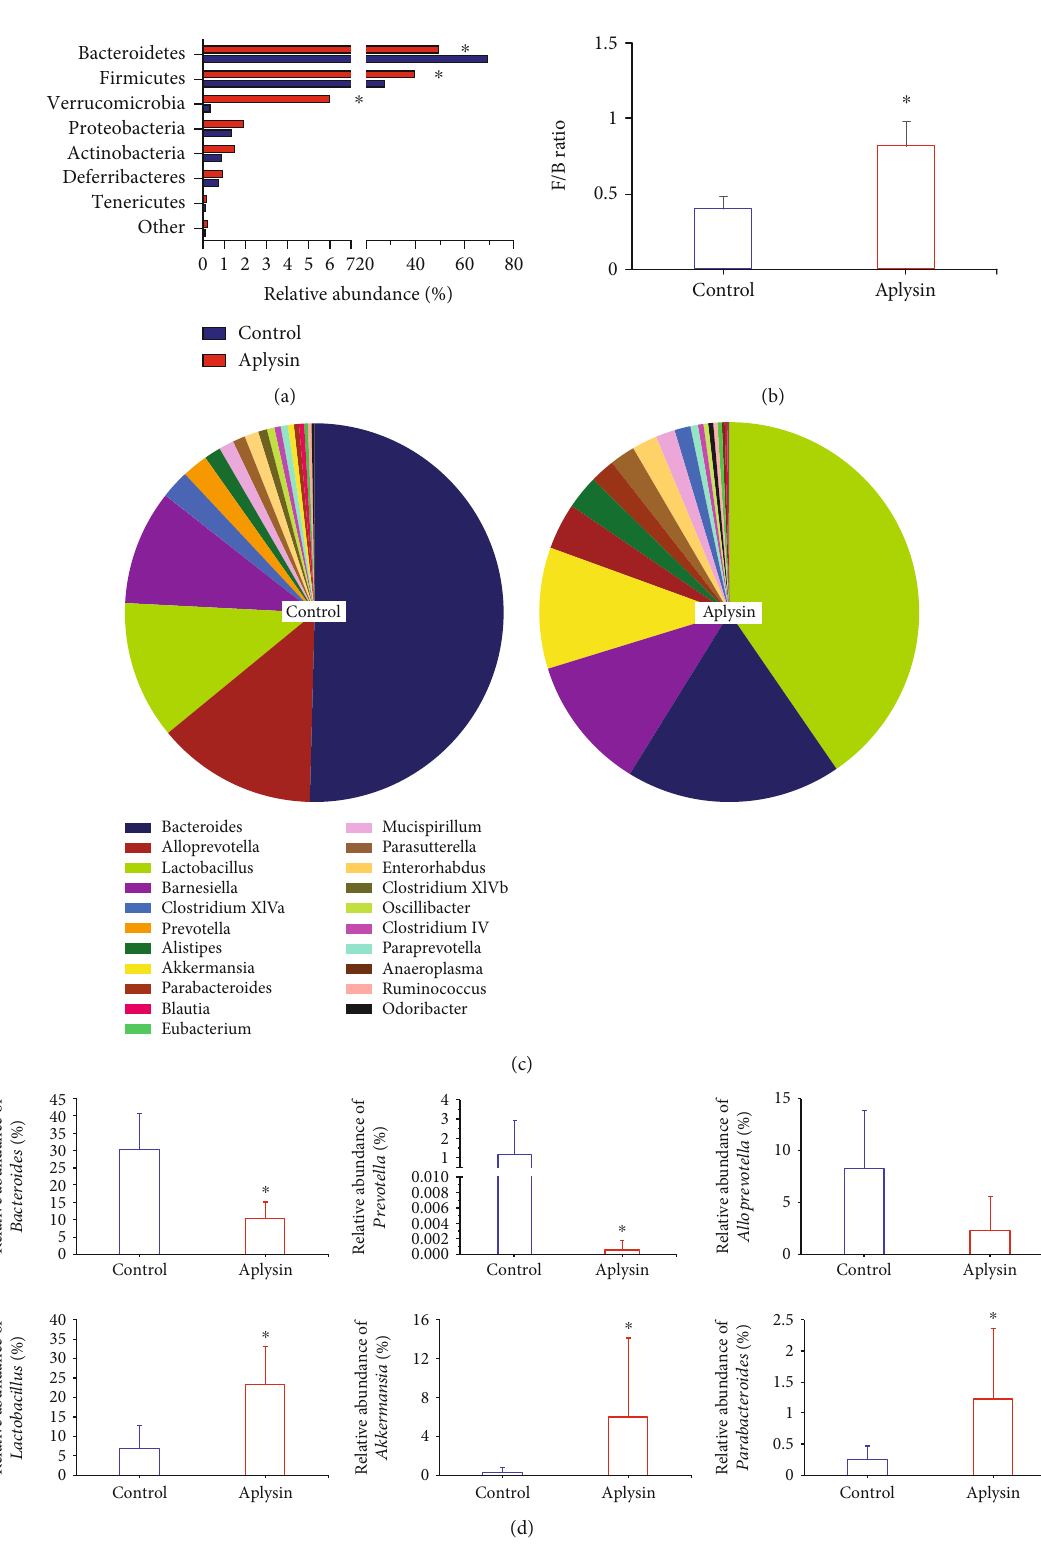
Figure 8: Analysis of the structure and composition of intestinal fl ora of mice. (a) Analysis of the relative abundance of bacteria at the phylum level. ∗ p < 0 : 05 vs. the control. (b) Analysis of the Firmicutes / Bacteroidetes (F/B) ratio of intestinal fl ora. ∗ p < 0 : 05 vs. the control. (c) Composition analysis of the dominant genera (top 20). (d) Changes in relative abundance of several important genera, including Bacteroides (upper left), Lactobacillus (bottom left), Akkermansia (bottom middle), Prevotella (upper middle), Parabacteroides (bottom right), and Alloprevotella (upper right), in intestinal fl ora. ∗ p < 0 : 05 vs. the